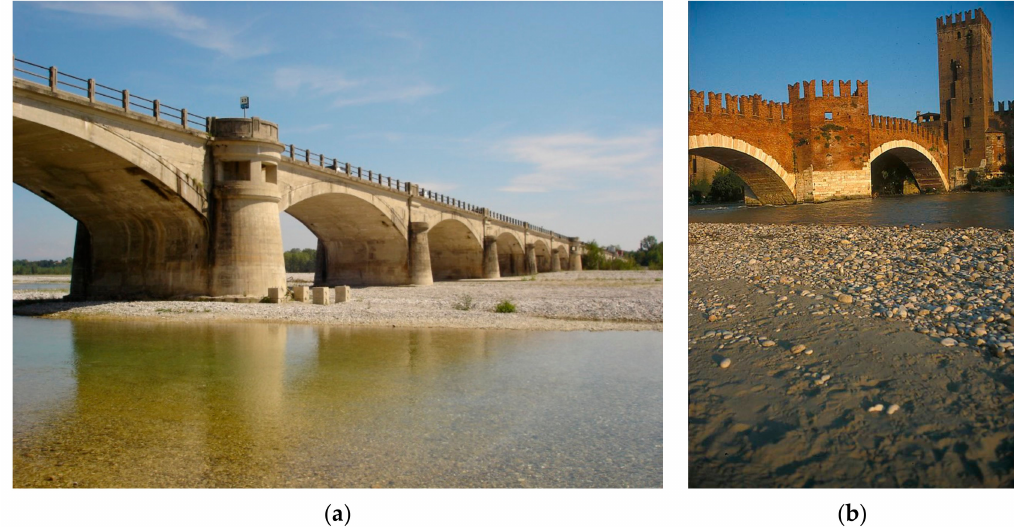
Figure 1. ( a ) Gravel-bars under a bridge, Tagliamento River, Italy (courtesy of Paolo Reggiani); ( b ) sediment sorting on a bar in the River Adige, at Castelvecchio Bridge, Verona,